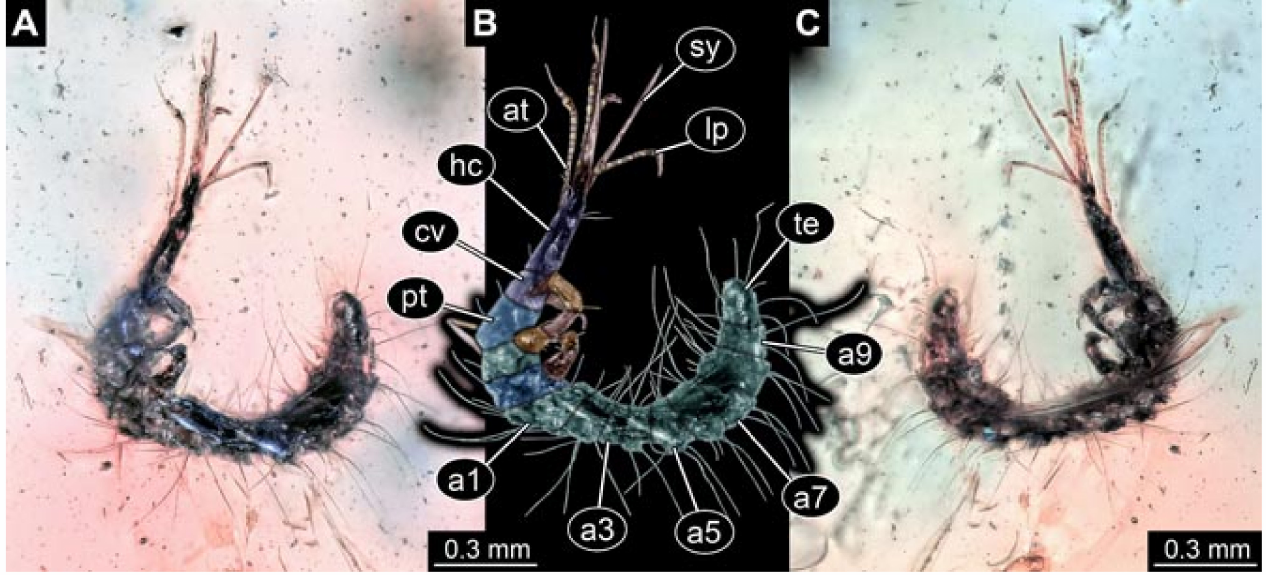
Figure 31. Specimen 5862 (PED 0790); Myanmar amber. ( A ) Dorso-lateral view. ( B ) Dorso-lateral view, colour-marked. ( C ) Ventro-lateral view. Abbreviations: a1–a9 = abdomen segments 1–9; at = antenna; cv = cervix; hc = head capsule; lp = labial palp; pt = prothorax; sy = stylet; te = trunk